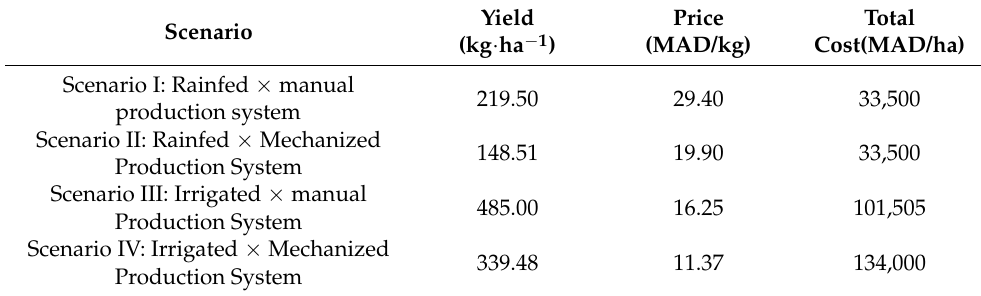
Figure 5. Monte Carlo simulation frequency of net profit as affected by a change in market price and yield. 1 USD = 9 MAD. Table 6. Break-even analysis. 1 USD = 9